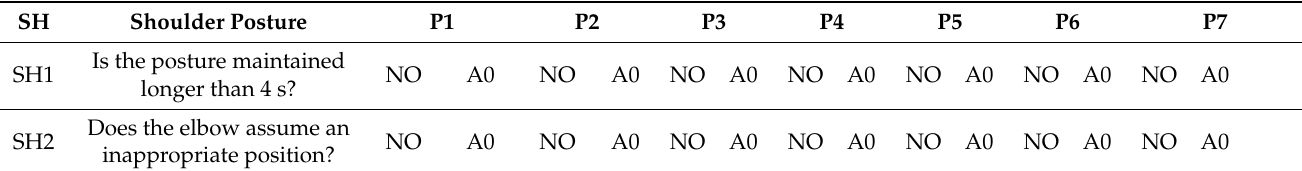
Table A3. Shoulder posture evaluation.